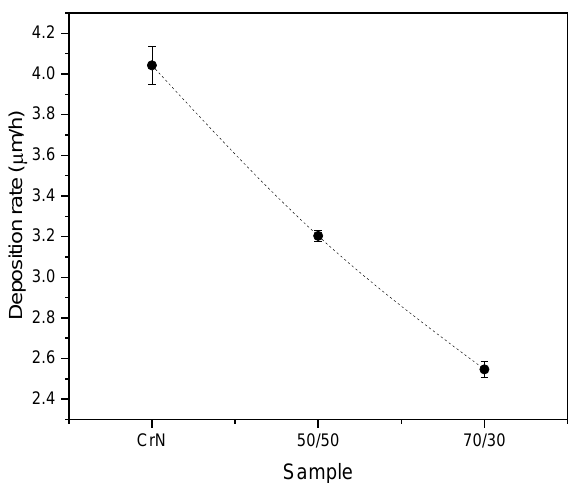
Figure 5. Deposition rate as a function of the Al/Cr ratio.